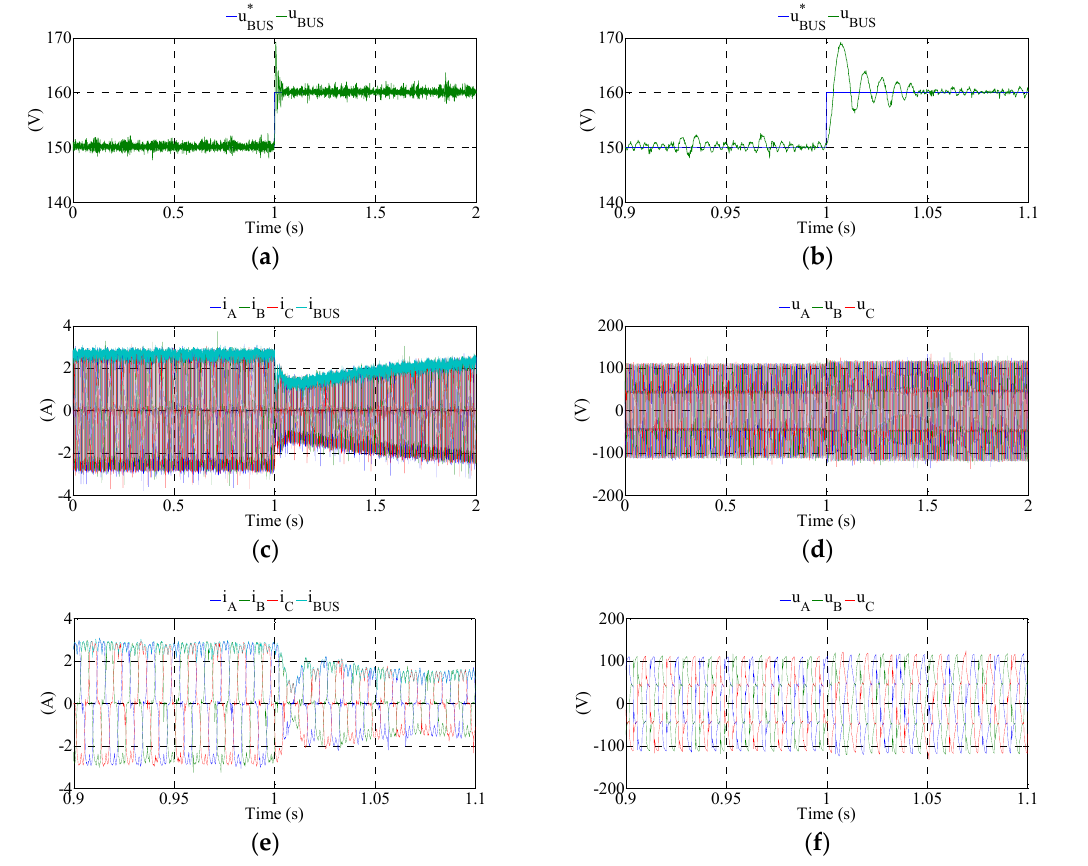
Figure 3. ( a ) BUS u response of hysteresis controller; ( b ) Enlarged BUS u response; ( c ) Experimental Figure 3. ( a ) u BUS response of hysteresis controller; ( b ) Enlarged u BUS response; ( c ) Experimental evolution of i A , i B , i C and i BUS ; ( d ) Experimental evolution of u A , u B , u C ; ( e ) Experimental evolution evolution of , , A B C i i i and BUS i ; ( d ) Experimental evolution of , , A B C u u u ; ( e ) Experimental evolution enlarged of i A , i B , i C and i BUS ; ( f ) Experimental evolution enlarged of u A , u B , u C enlarged of , , A B C i i i and BUS i ; ( f ) Experimental evolution enlarged of , , A B C u u u .